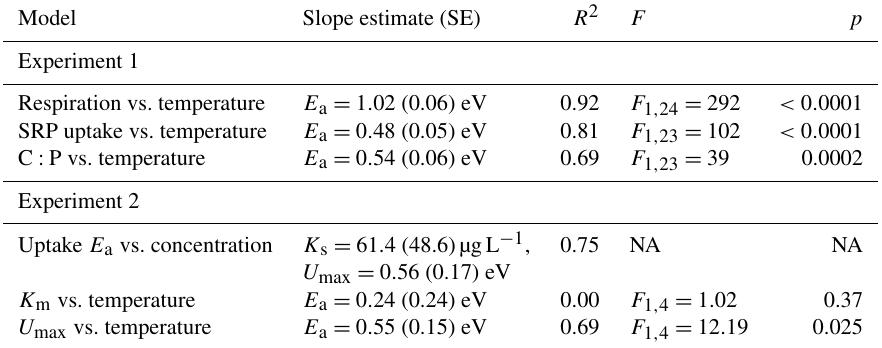
Table 2. Parameter estimates and model fit from laboratory experiments. In the first experiment, Rhododendron maximum leaves were incubated at five temperatures ranging from 4–20 ◦ C and rates of soluble reactive phosphorus (SRP) uptake and respiration were measured. In the second experiment, Acer rubrum leaves were incubated with different initial concentrations of phosphorus at different temperatures. We report slopes of the models along with the standard error (SE), the model R 2 , and the F value and p value associated with the slope